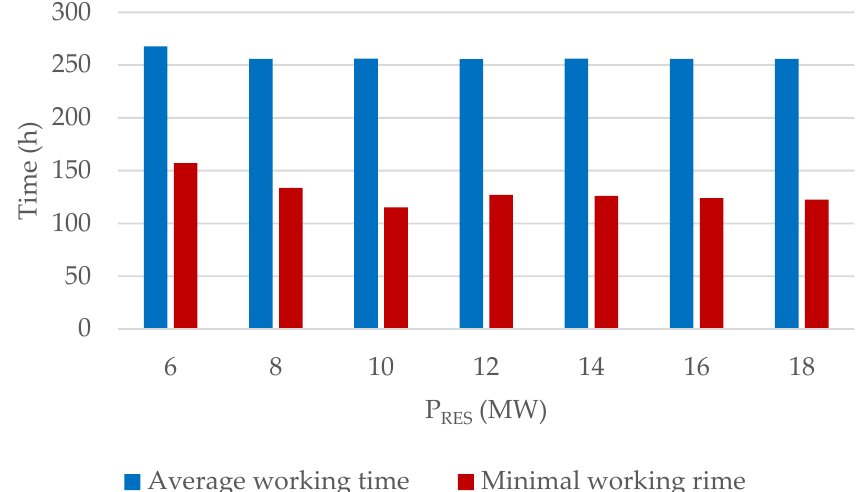
Figure 10. Average and minimum operation time of the gasifier.